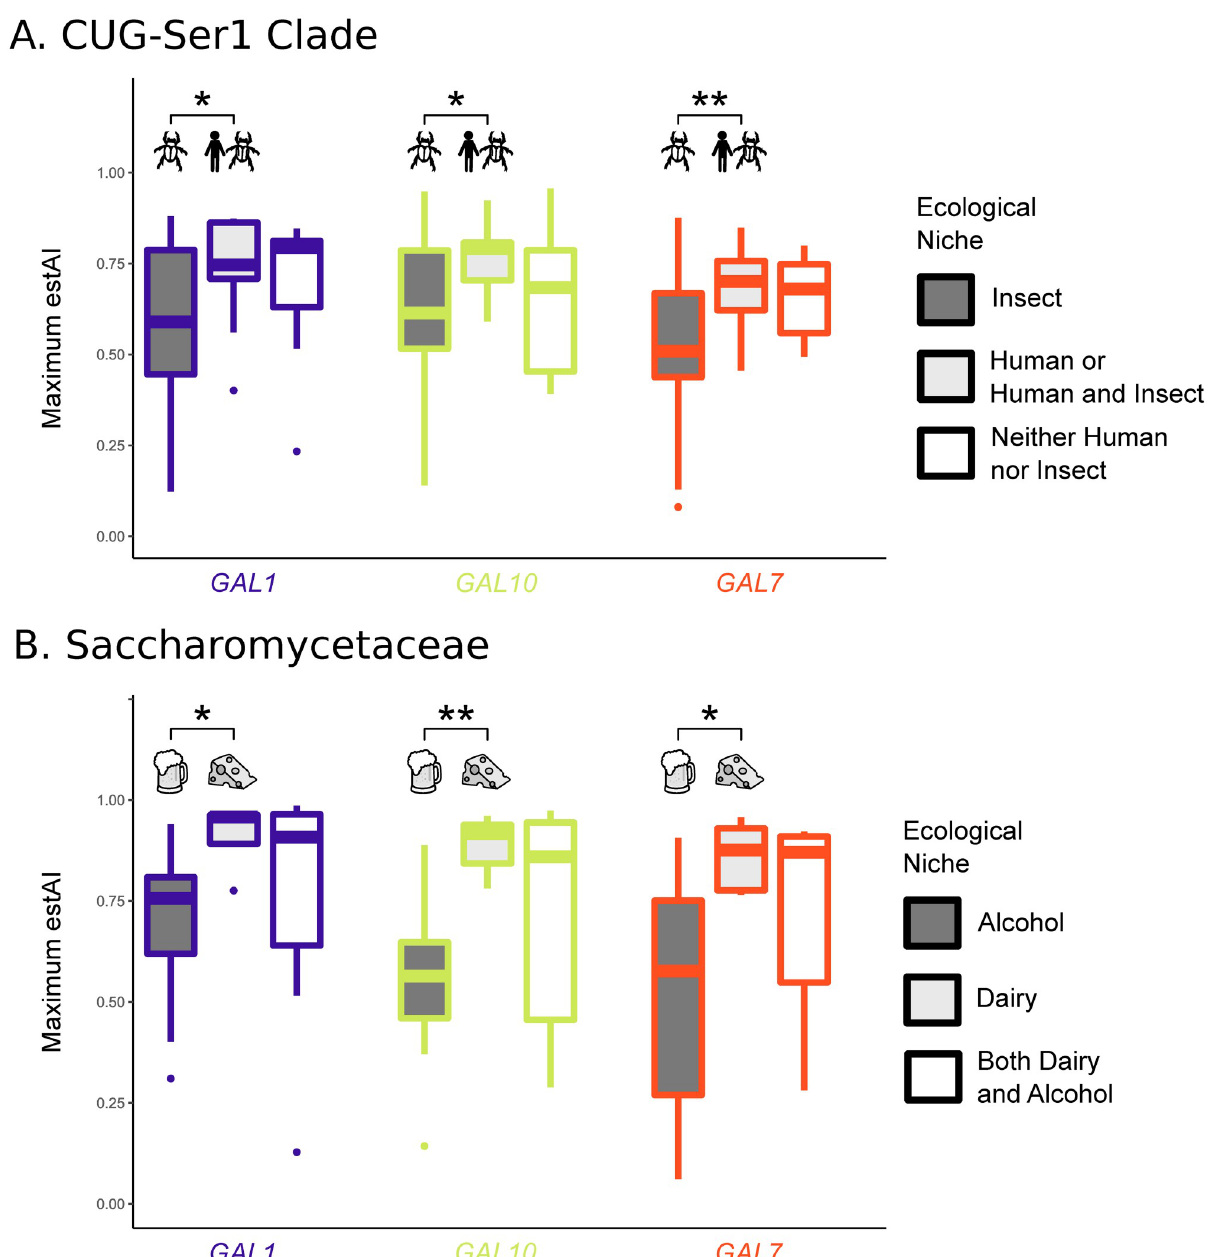
Fig 3. Codon optimization in the GAL pathway is correlated with specific ecological niches in 2 different major clades of budding yeasts. p -values less than 0.01 are indicated with �� and less than 0.05 with � . (A) In the CUG-Ser1 clade, species associated with a human niche or human and insect niches (13 species) have significantly higher codon usage optimization values in all GAL genes ( p -values of 0.022, 0.028, and 0.006 for GAL1 , GAL10 , and GAL7 , respectively) when compared to species that are associated with insect niches but not human niches (44 species). Only 11 species were not associated with either human or insect niches. (B) In the Saccharomycetaceae, species associated with only dairy niches (5 species) have significantly higher codon usage optimization values in all of the GAL genes ( p -values of 0.010, 0.002, and 0.014 for GAL1 , GAL10 , and GAL7 , respectively) versus species associated with only alcohol niches (14 species). A total of 9 species are associated with both dairy and alcohol niches. Underlying data can be found in Tables E and F S4 Data.